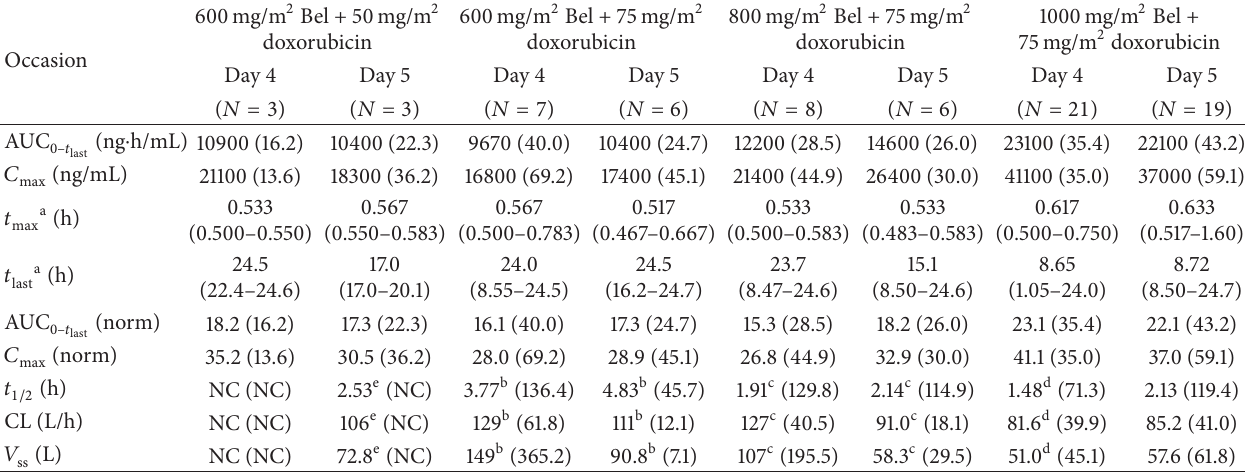
Table 4: Pharmacokinetic parameters of belinostat (Bel) following administration of Bel alone (cycle 1 day 4) or in combination with doxorubicin (cycle 1 day